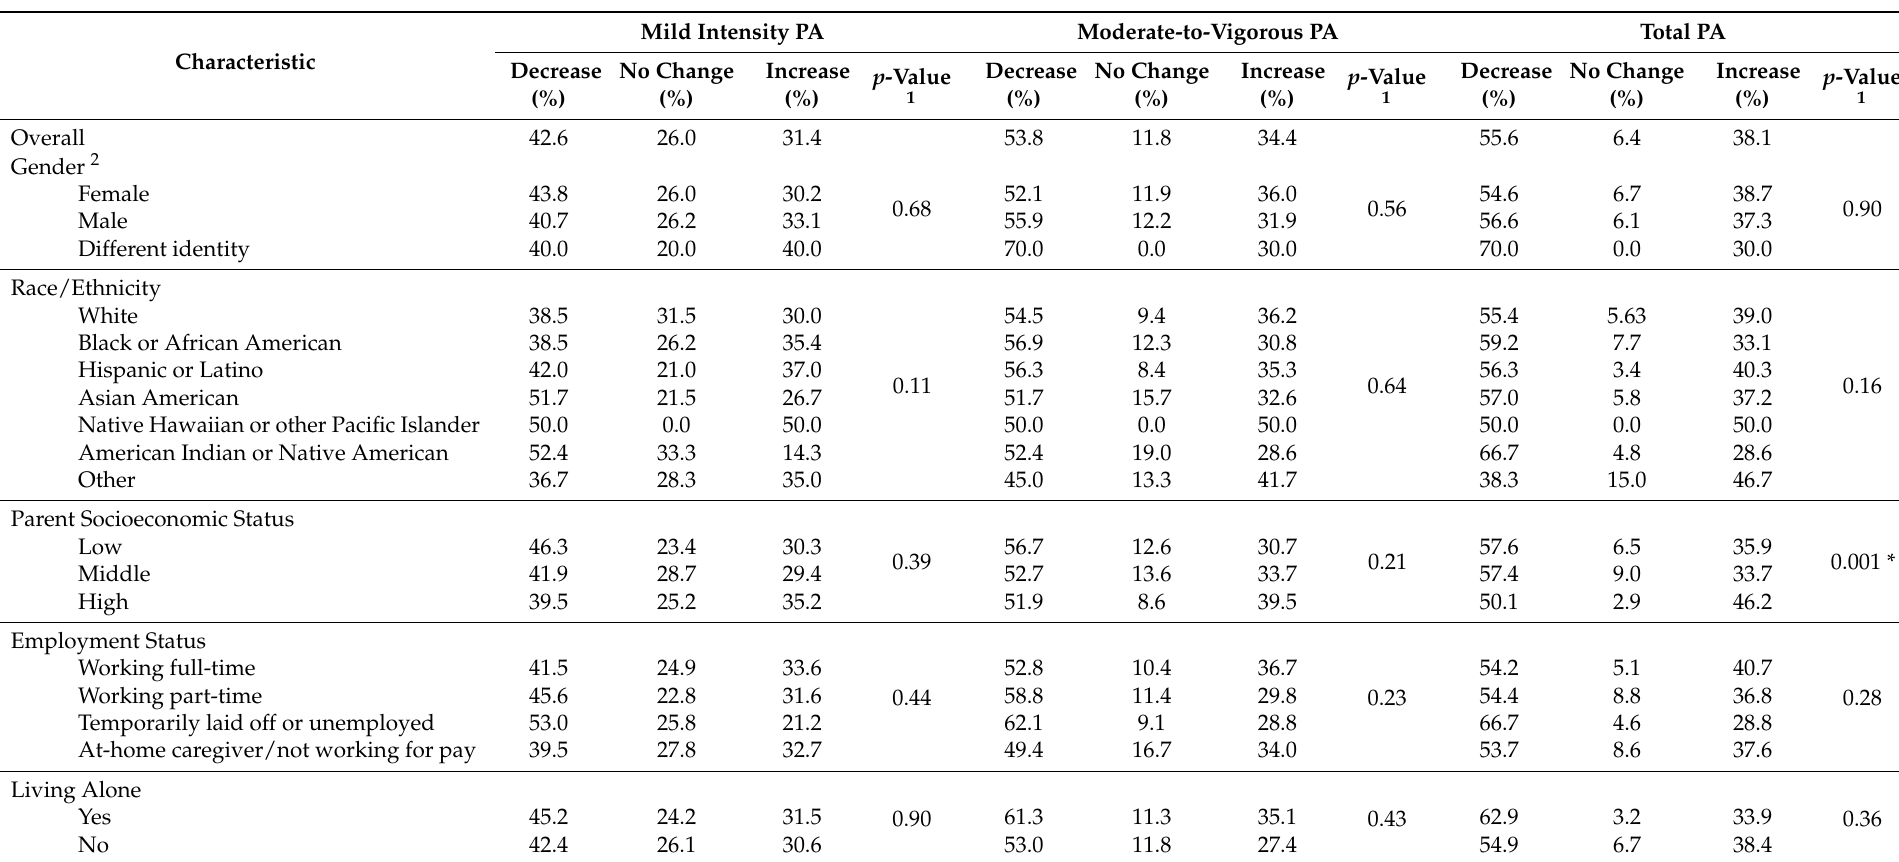
Table 2. Bivariate associations between changes in PA (% decrease, no change, or increase) from 2018 to 2020 during the COVID-19 pandemic by sociodemographic characteristics.